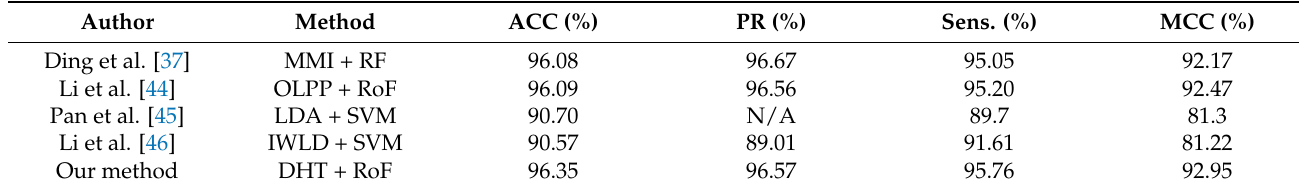
Table 7. Performance comparisons of computational methods on the Human